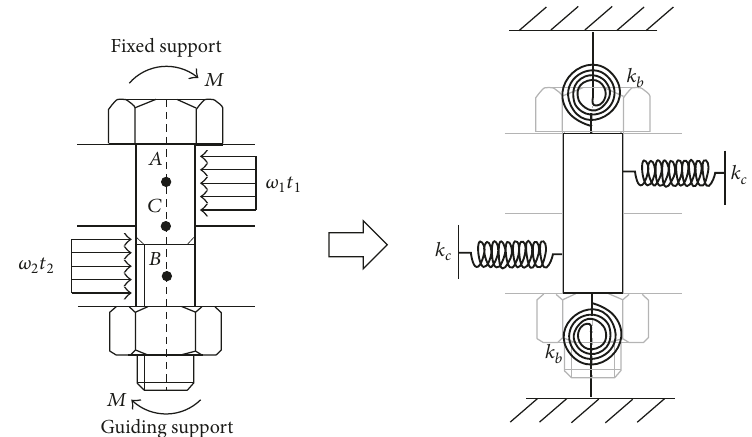
Figure 13: Stiffness components of single bolt